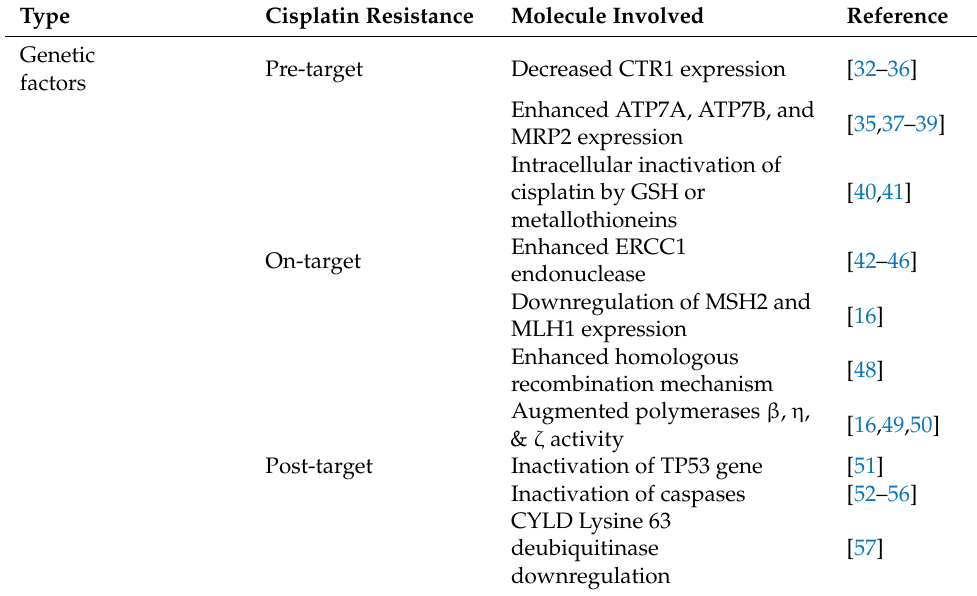
Table 1. Factors regulating genetic and epigenetic mechanisms during cisplatin